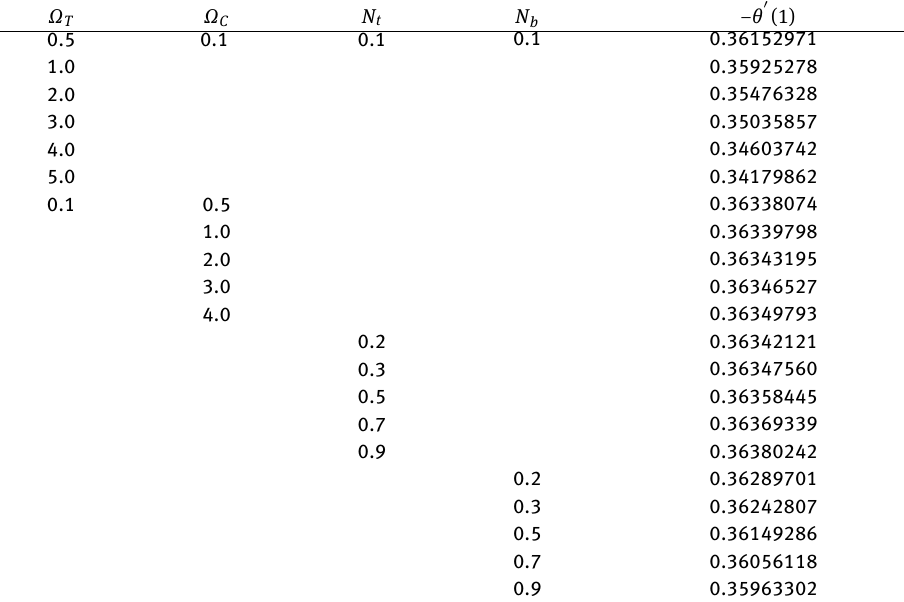
Table 5: Numerical values of heat transfer rate for various values of Ω T , Ω C , N t and N b with fixed S = 0.4, β = 1.4, Ha = 0.1, Pr = 0.7, Ec = 0.1, Sc = 0.7 and Kr = 0.1